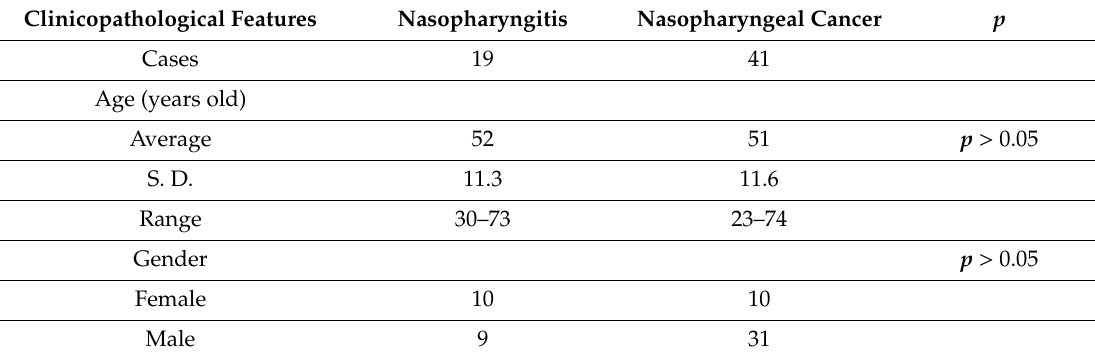
Table 1. Patient demographics of NPC and nasopharyngitis